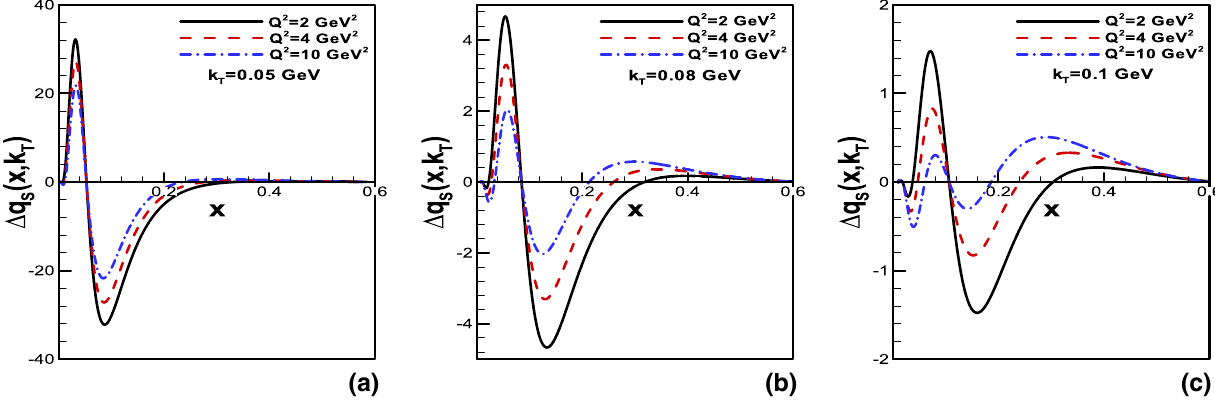
Fig. 13 The x -distribution of total polarized sea quarks at a k T = 0 . 05 GeV, b k T = 0 . 08 GeV and c k T = 0 . 1 GeV. The TMD polarized sea distributions are plotted at three values of Q